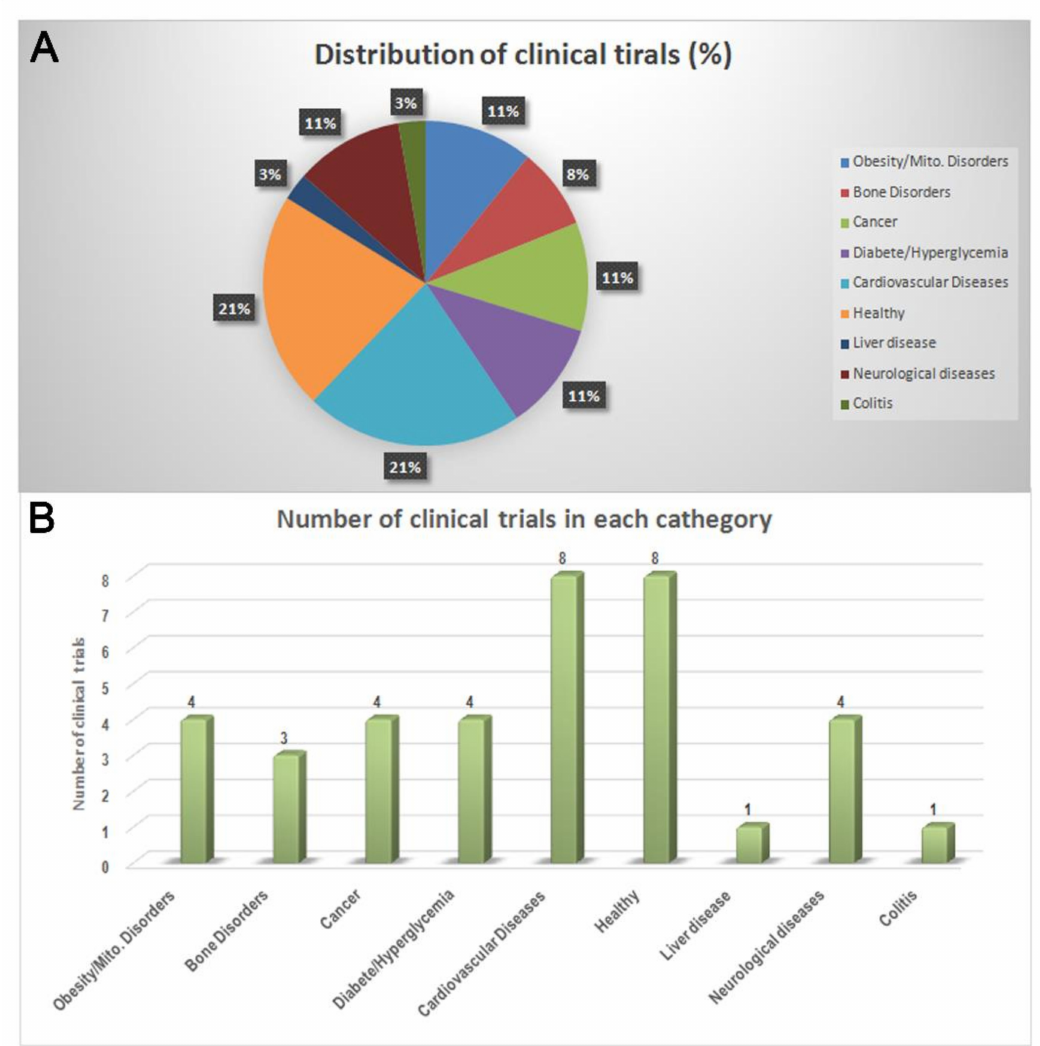
Figure 3. ( A ) The number and ( B ) percentage of OO- and OOP-based clinical trials classified according to the indications provided by clinical trials database. Data from http://www.clinicaltrials.gov/ (15 March